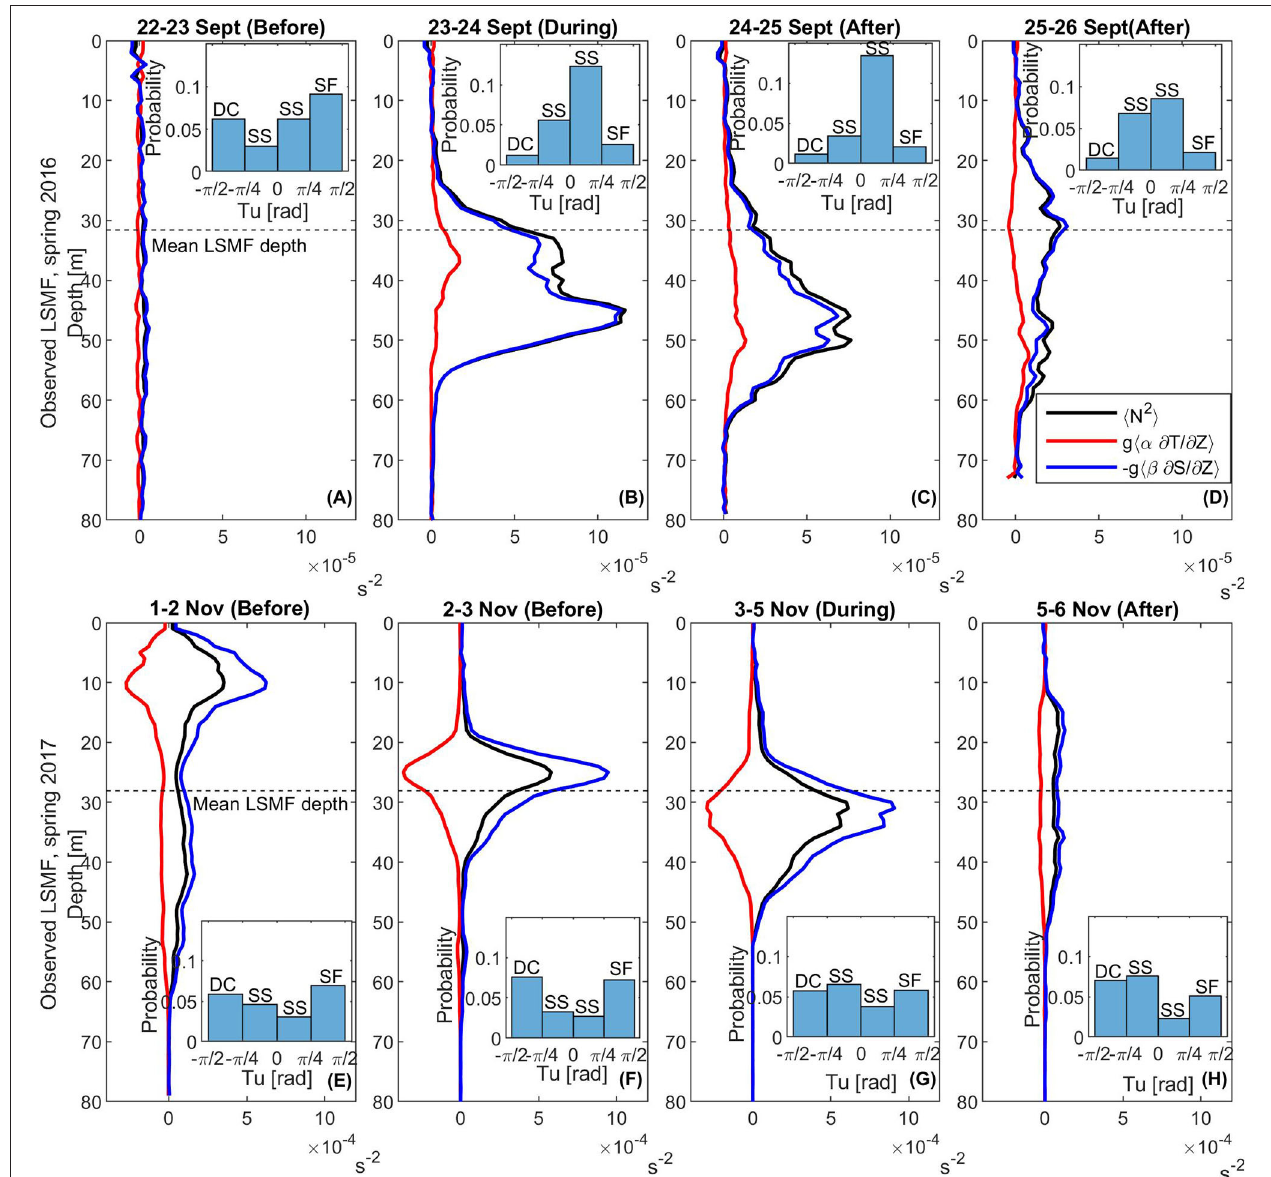
FIGURE 5 | Vertical stratification N 2 (s − 2 , in black), with contributions from temperature (red) and salinity (blue) before, during and after sampling observed LSMF in 2016 (top panel) and observed LSMF in spring 2017 (bottom panel). The angled brackets represent averaging over a certain number of profiles sampled before, during and after observed LSMF in 2016 (over 150 profiles) and observed LSMF in 2017 (over 250 profiles). Mean LSMF depth for each LSMF in black dashed lines. Histograms of probability density function of Turner angle, Tu for all data points (A,E,F) before, (B,G) during, and (C,D,H) after the two LSMFs. Note the different scale for N 2 for the two surveys. DC, Diffusive convection; SS, Statically stable; and SF, Salt